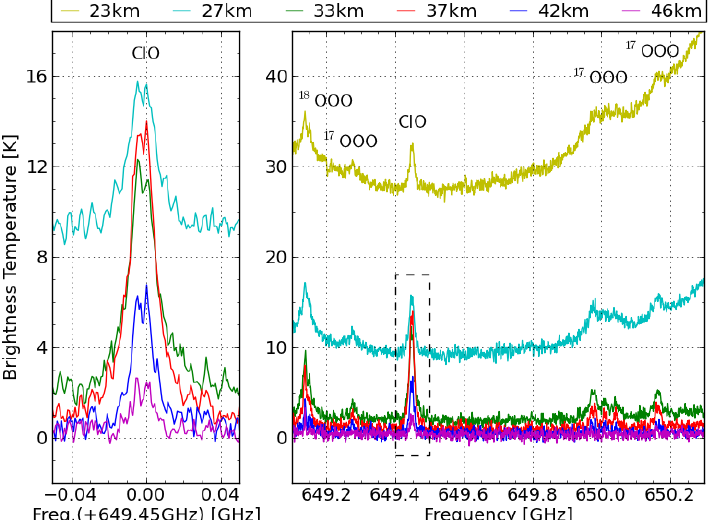
Fig. 1. Single-scan Band C spectra observed by SMILES at tangent heights of 23, 27, 33, 37, 42 and 46 km. The frequency is calibrated by considering Doppler shift. The figure at left is a magnification of the ClO transitions at 649.445 and 649.451 GHz. The figure at right shows the full frequency region for Band C. Date: 9 November 2009. Local time: 00:22. Latitude: 57.2 ◦ N. Longitude: 6.4 ◦ E.